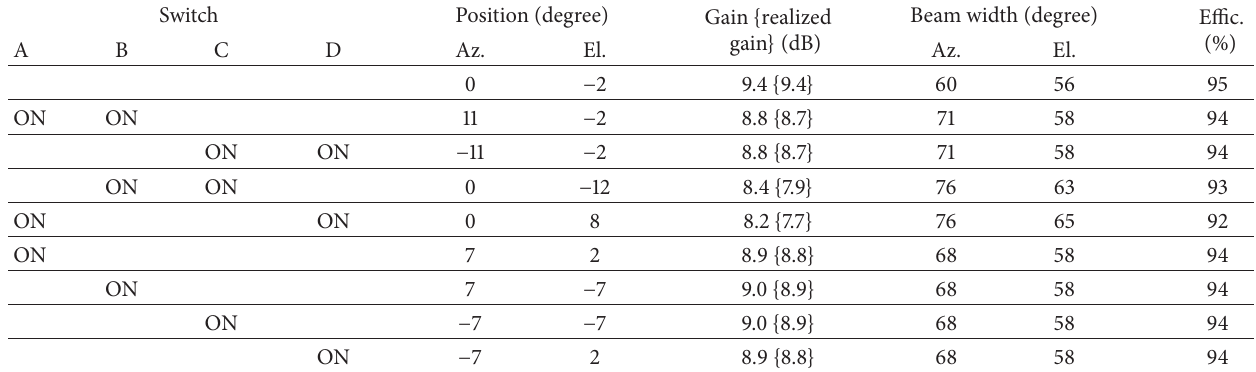
Table 2: Reconfigurable antenna simulated pattern parameters.